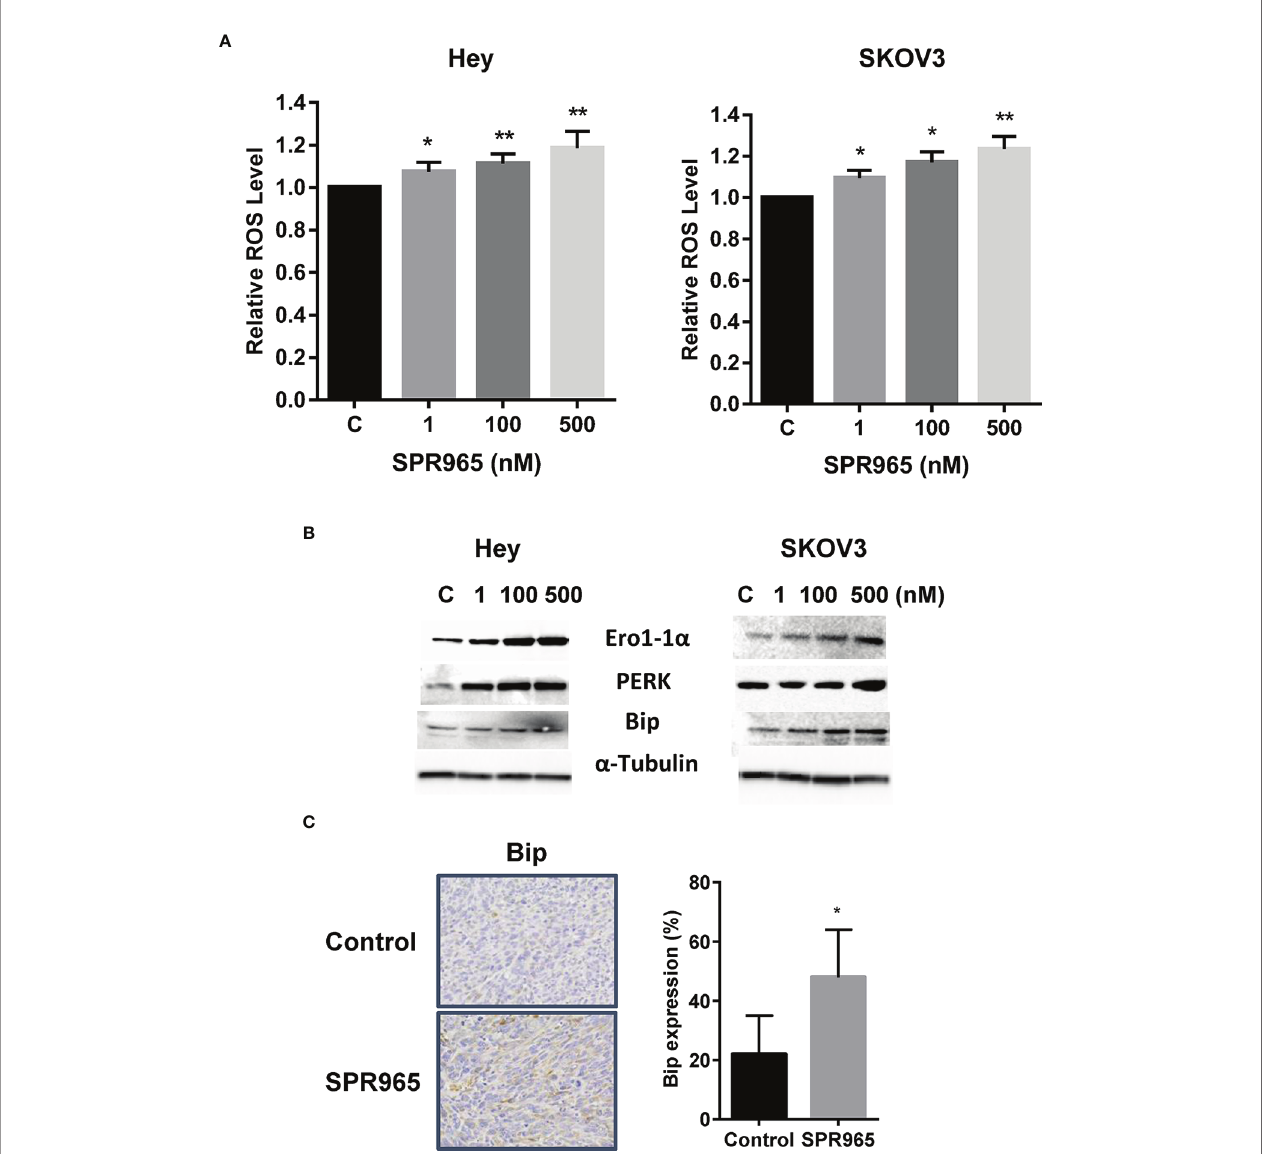
FIGURE 4 | SPR965 induced endoplasmic reticulum (ER) stress in ovarian cancer cells. The Hey and SKOV3 cells were treated with SPR965 at different concentrations for 8 h. Reactive oxygen species (ROS) products were measured by DCFH-DA assay. SPR965 signi fi cantly increased the levels of ROS in both cell lines compared to the control cells (A) . Western blotting results showed that SPR965 increased the expression of cellular stress-related proteins including PERK, Ero1, and Bip in both cell lines after treatment for 24 h (B) . Immunohistochemistry results showed that SPR965 increased the expression of Bip in the ovarian tumors of KpB mice (C) . The results are shown as the mean ± SD and are representative of three independent experiments. *p<0.05,